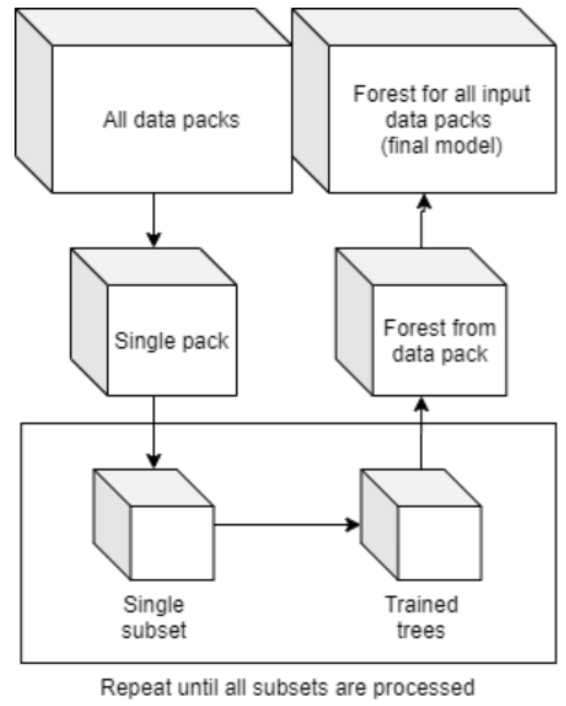
Figure 16. Process of generating